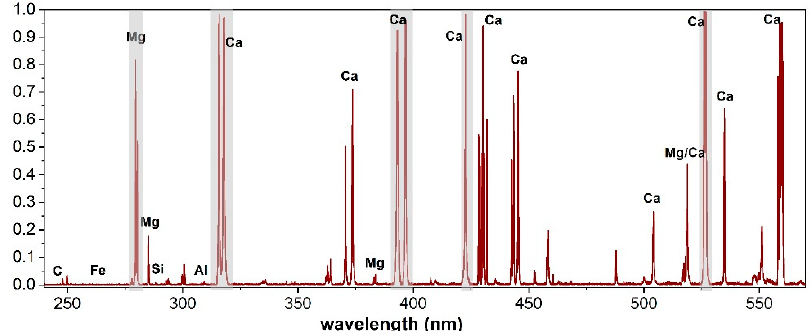
Figure 1. Portion of LIBS spectrum of sample P 31 with excluded wavelength bands in gray (see text).